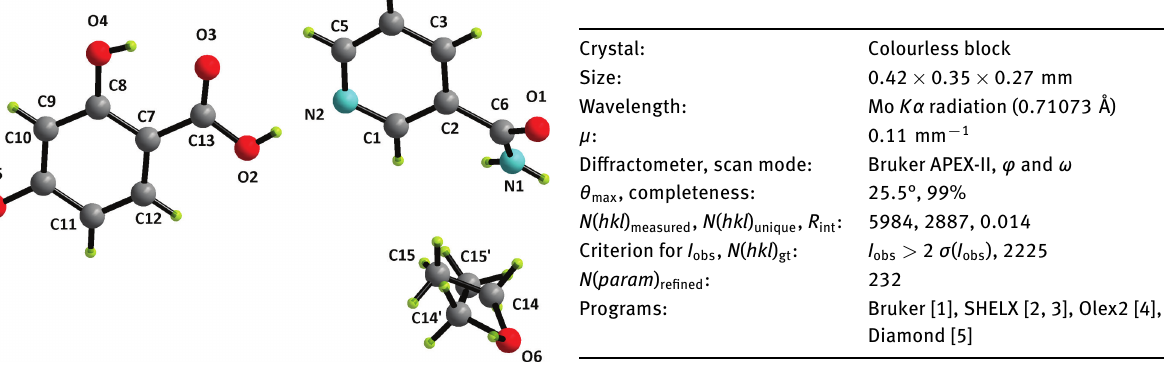
Table 1: Data collection and